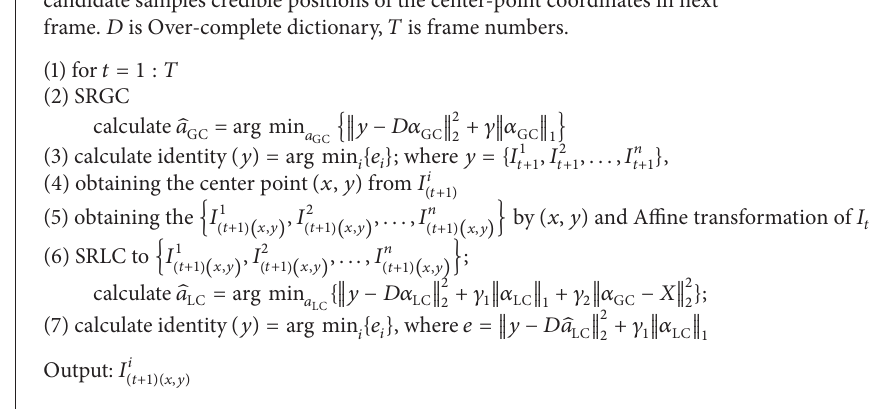
Algorithm 1: Algorithm of Fisher discrimination dictionary